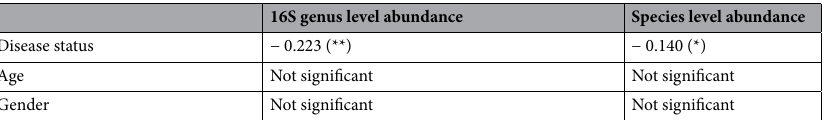
Table 3. Joint contributions of disease status, age and gender on alpha diversity. Coefficients and statistical significance of the factors are quantified by a linear model 2. If a regression coefficient is reported, its